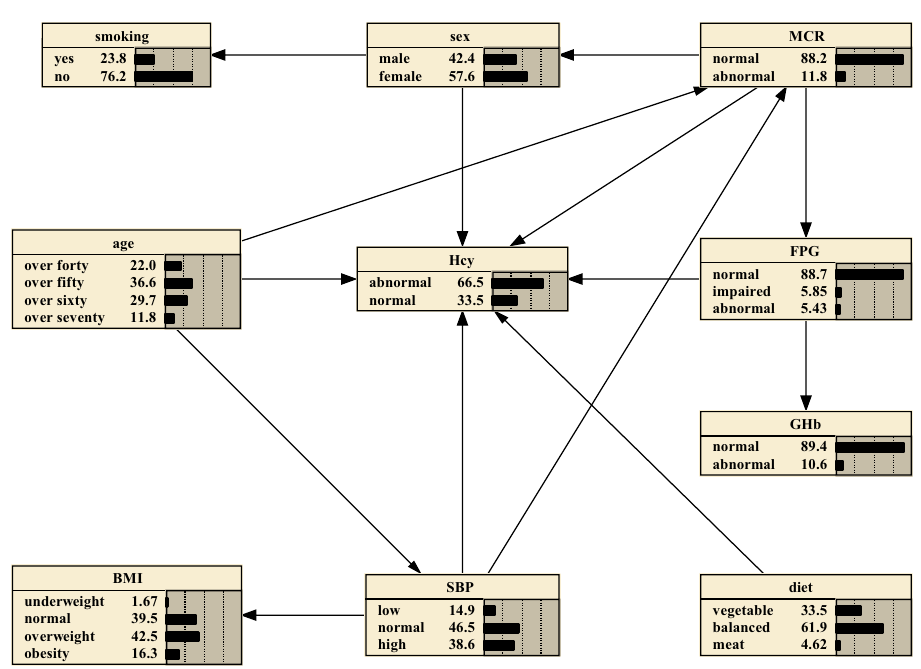
Figure 1. Tabu-search algorithm to construct HHcy Bayesian networks and prior probability. The figure was plotted using Netica (www. norsys.